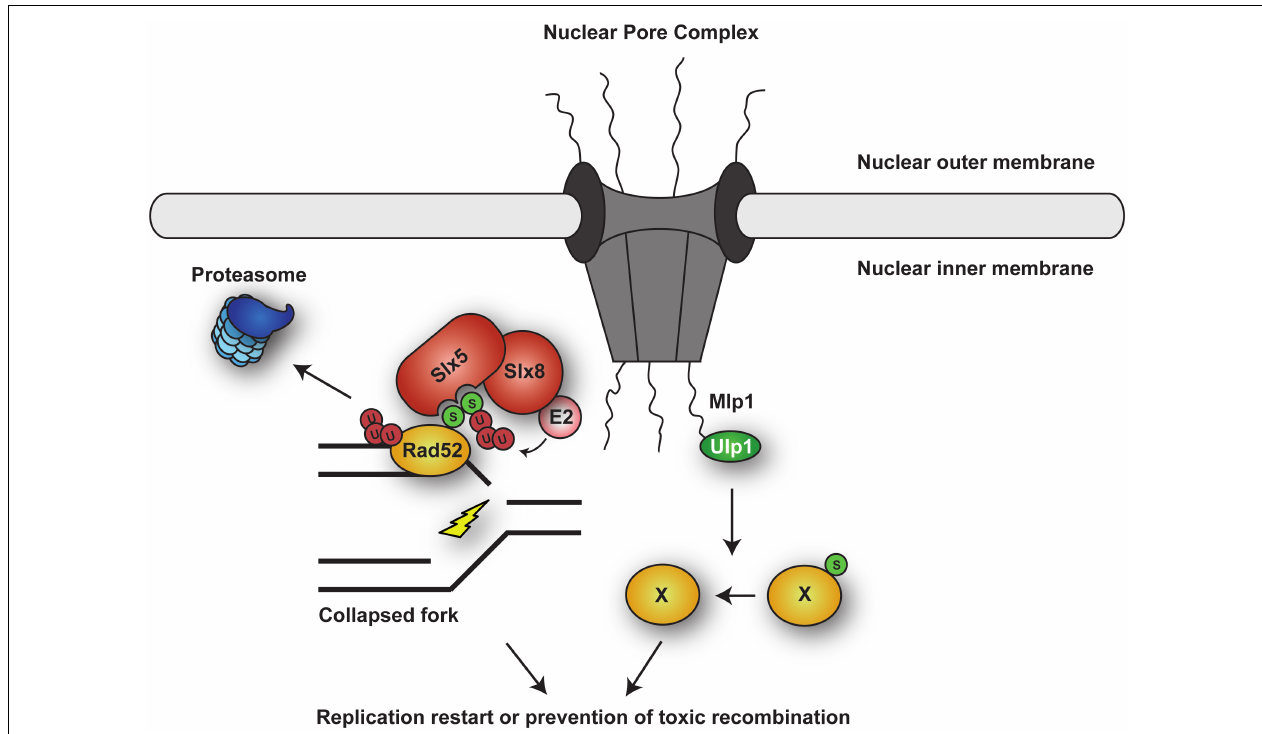
FIGURE 7 | Spatial organization of ubiquitin and SUMO metabolism in the nucleus. Both ubiquitin and SUMO conjugating and deconjugating enzymes are enriched at the Nuclear Pore Complex (NPC). Collapsed forks relocalize to NPCs, which modulates local ubiquitylation and/or SUMOylation of relevant components in order to facilitate fork restart or prevent toxic recombination